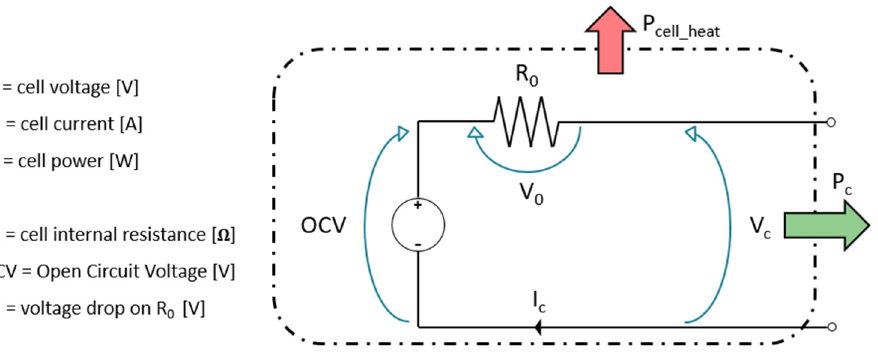
Figure 4. Equivalent Circuit Battery Model—Battery cell modelling [22].